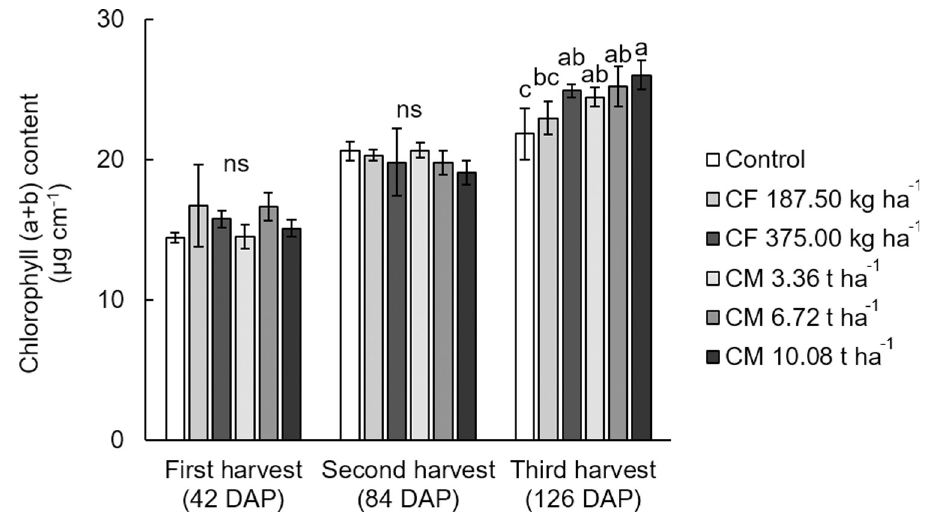
Fig 1. Chlorophyll (a+b) content ( μ g cm -2 ) in the above-ground (leave and stem) of white mugwort under the fertilizer treatments. The different letters above the bars indicate statistically significant differences by Duncan’s multiple range tests (p < 0.05) within each harvest. CF = chemical fertilizer (complete fertilizer 25-7-7 grade + urea 46- 0-0 grade); CM = chicken